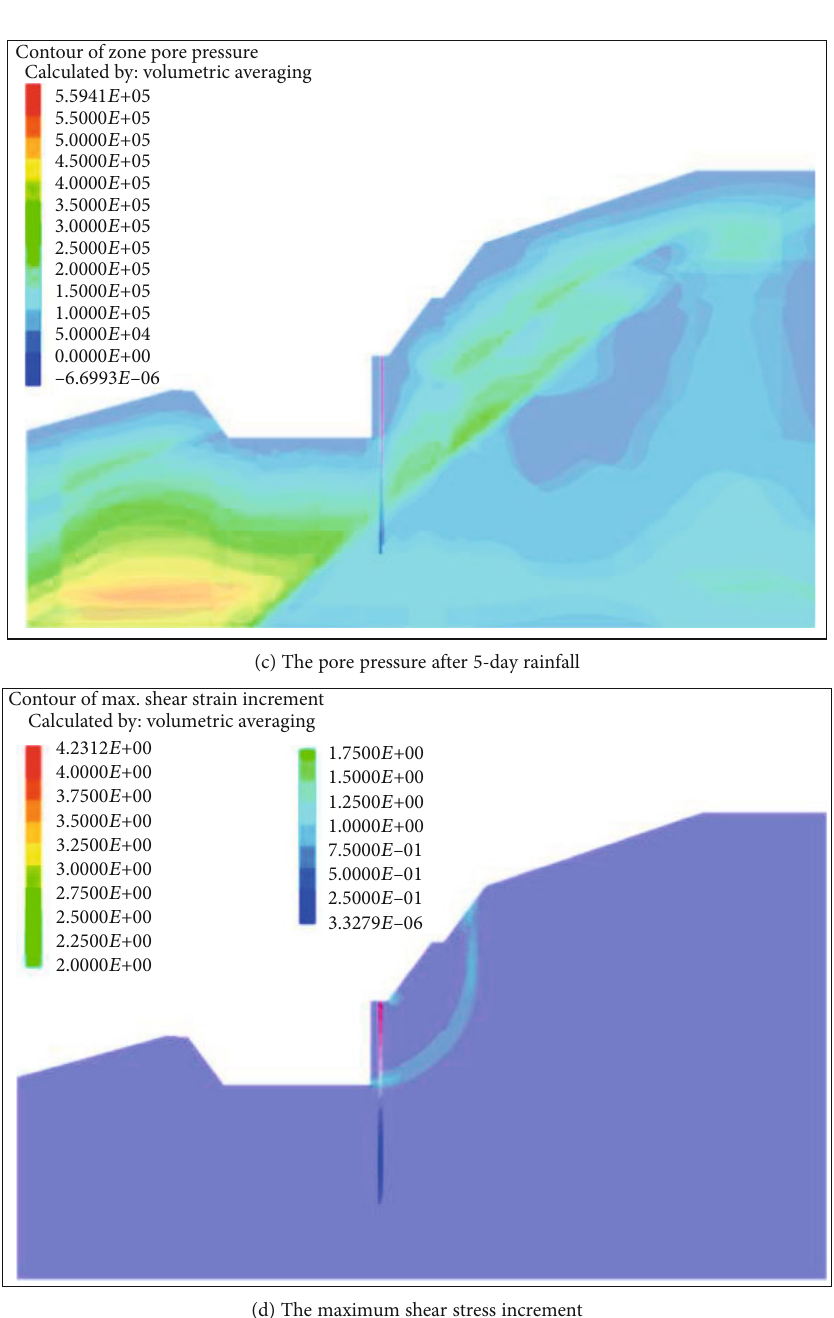
Figure 8: Coupled analysis results of the cut slope with the actual construction